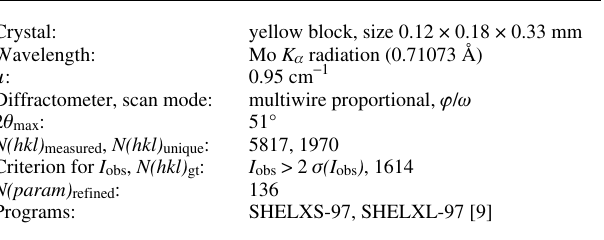
Table 1. Data collection and handling.